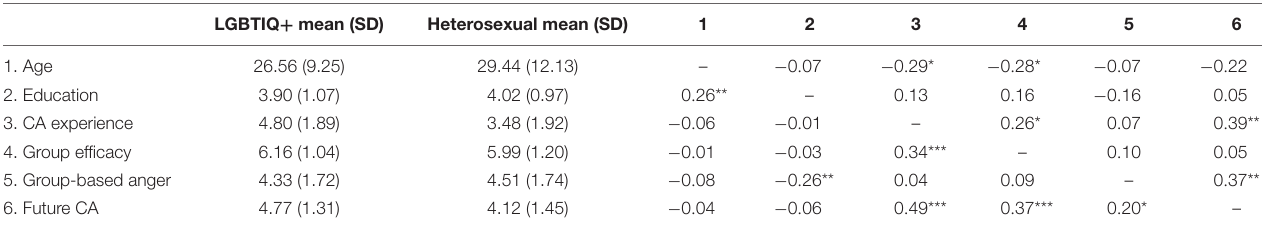
TABLE 1 | Means, standard deviations, and correlations between the